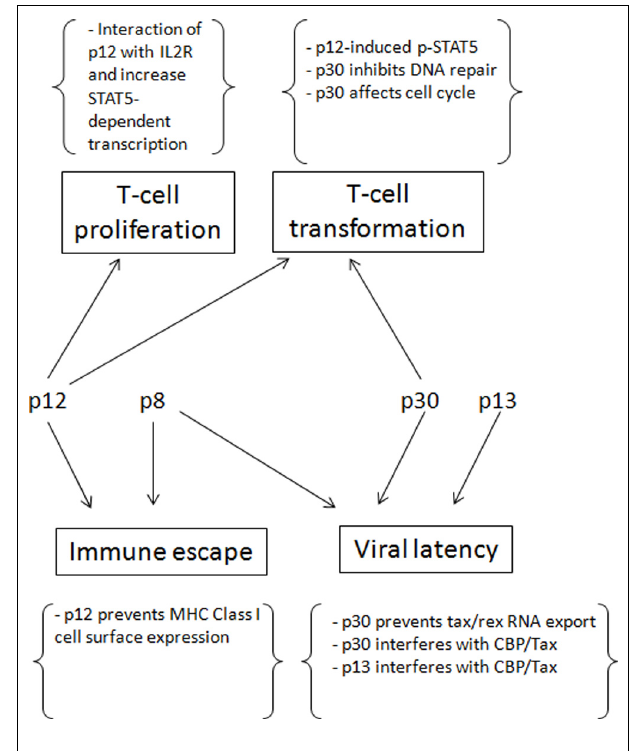
FIGURE 2 |The contributions of p12, p8, p30 and p13 for the establishment of persistent infection and cell transformation.